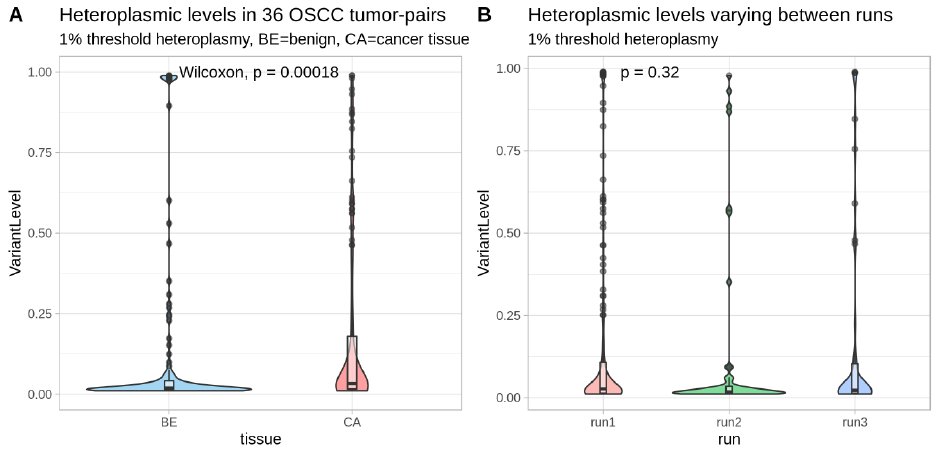
Figure 3. Violin- and Boxplots showing heteroplasmy levels in 36 sample pairs. The median heteroplasmy levels in the benign tissues corresponding to 1.9% are lower than in cancer tissues with a median of 3.3% when applying a 1% threshold. The p -value was derived from the Wilcoxon test ( A ). Heteroplasmic variant levels in the three different sequencing runs (run1: HiSeq run filtered with n = 27, run2: Miseq run with n = 5, run3: MiSeq run with n = 4) with the cutoff at 1%. The p -value was derived from the Kruskal – Wallis test ( B ).